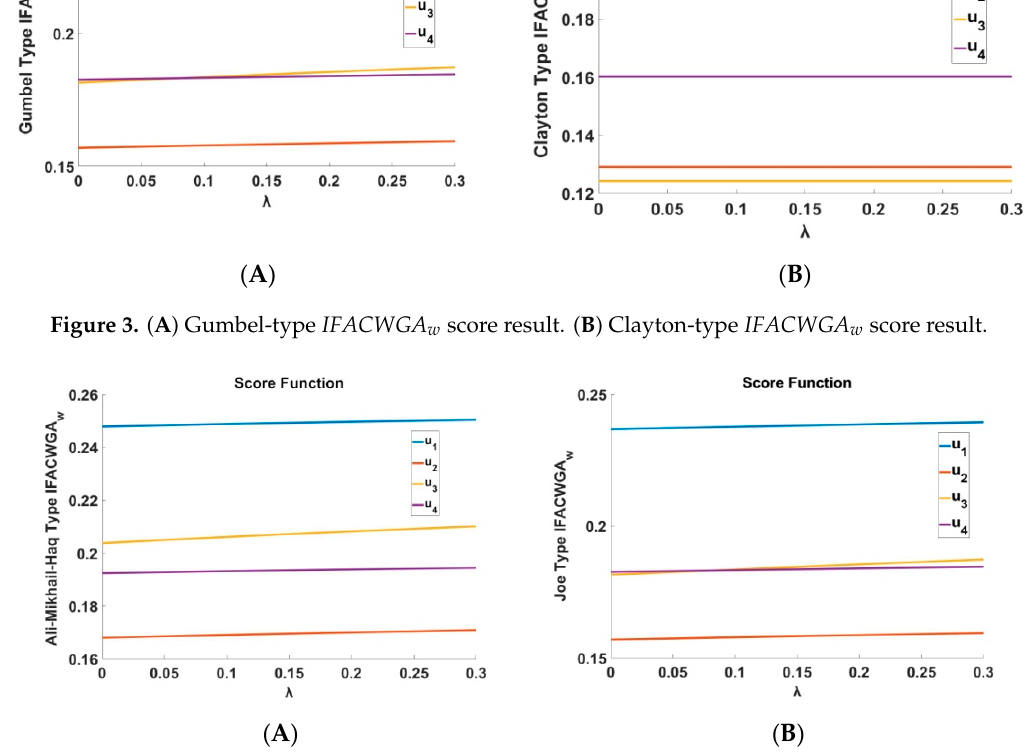
IFACWGA score result. ( B ) Joe-type w